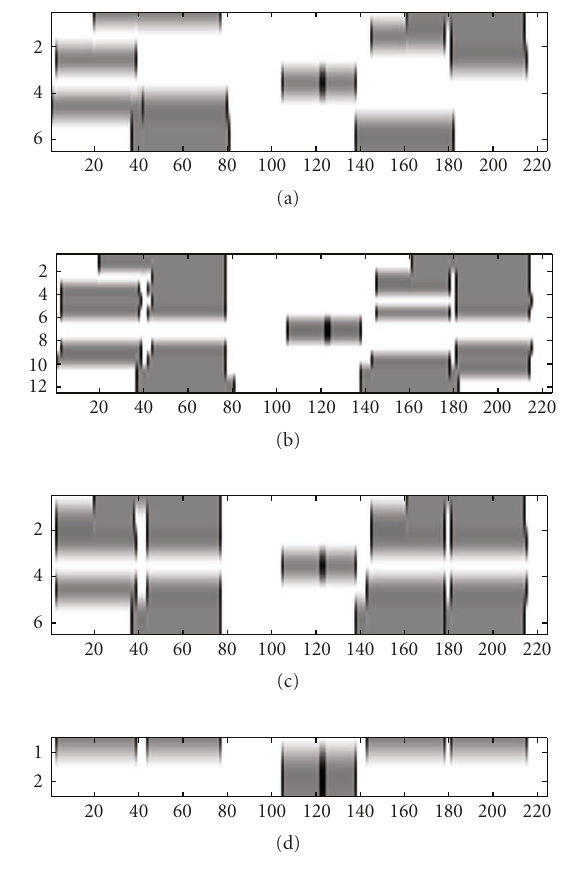
Figure 11: Illustration of the clustering algorithm for the Shostakovich example. The path set P = { P 1 , ... , P 6 } is shown in Figure 10(b). Segments are indicated by gray bars and overlaps are indicated by black regions. (a) Illustration of the two segments P π P P P , 1 ≤ m ≤ 6. Row m π m ) and m ) for each path m ∈ 1 ( 2 ( corresponds to P m . (b) Clusters A 1 m and A 2 m (rows 2 m − 1 and 2 m ) computed in step (1) with T ts = 90. (c) Clusters A m (row m ) com- puted in step (2). (d) Final result of the clustering algorithm after performing step (3) with T dc = 90. The derived global structure is given by two similarity clusters. The first cluster corresponds to the musical parts { A 1 , A 2 , A 3 , A 4 } (first row) and the second cluster to C { C } (second row) (cf. Figure 1 , 2